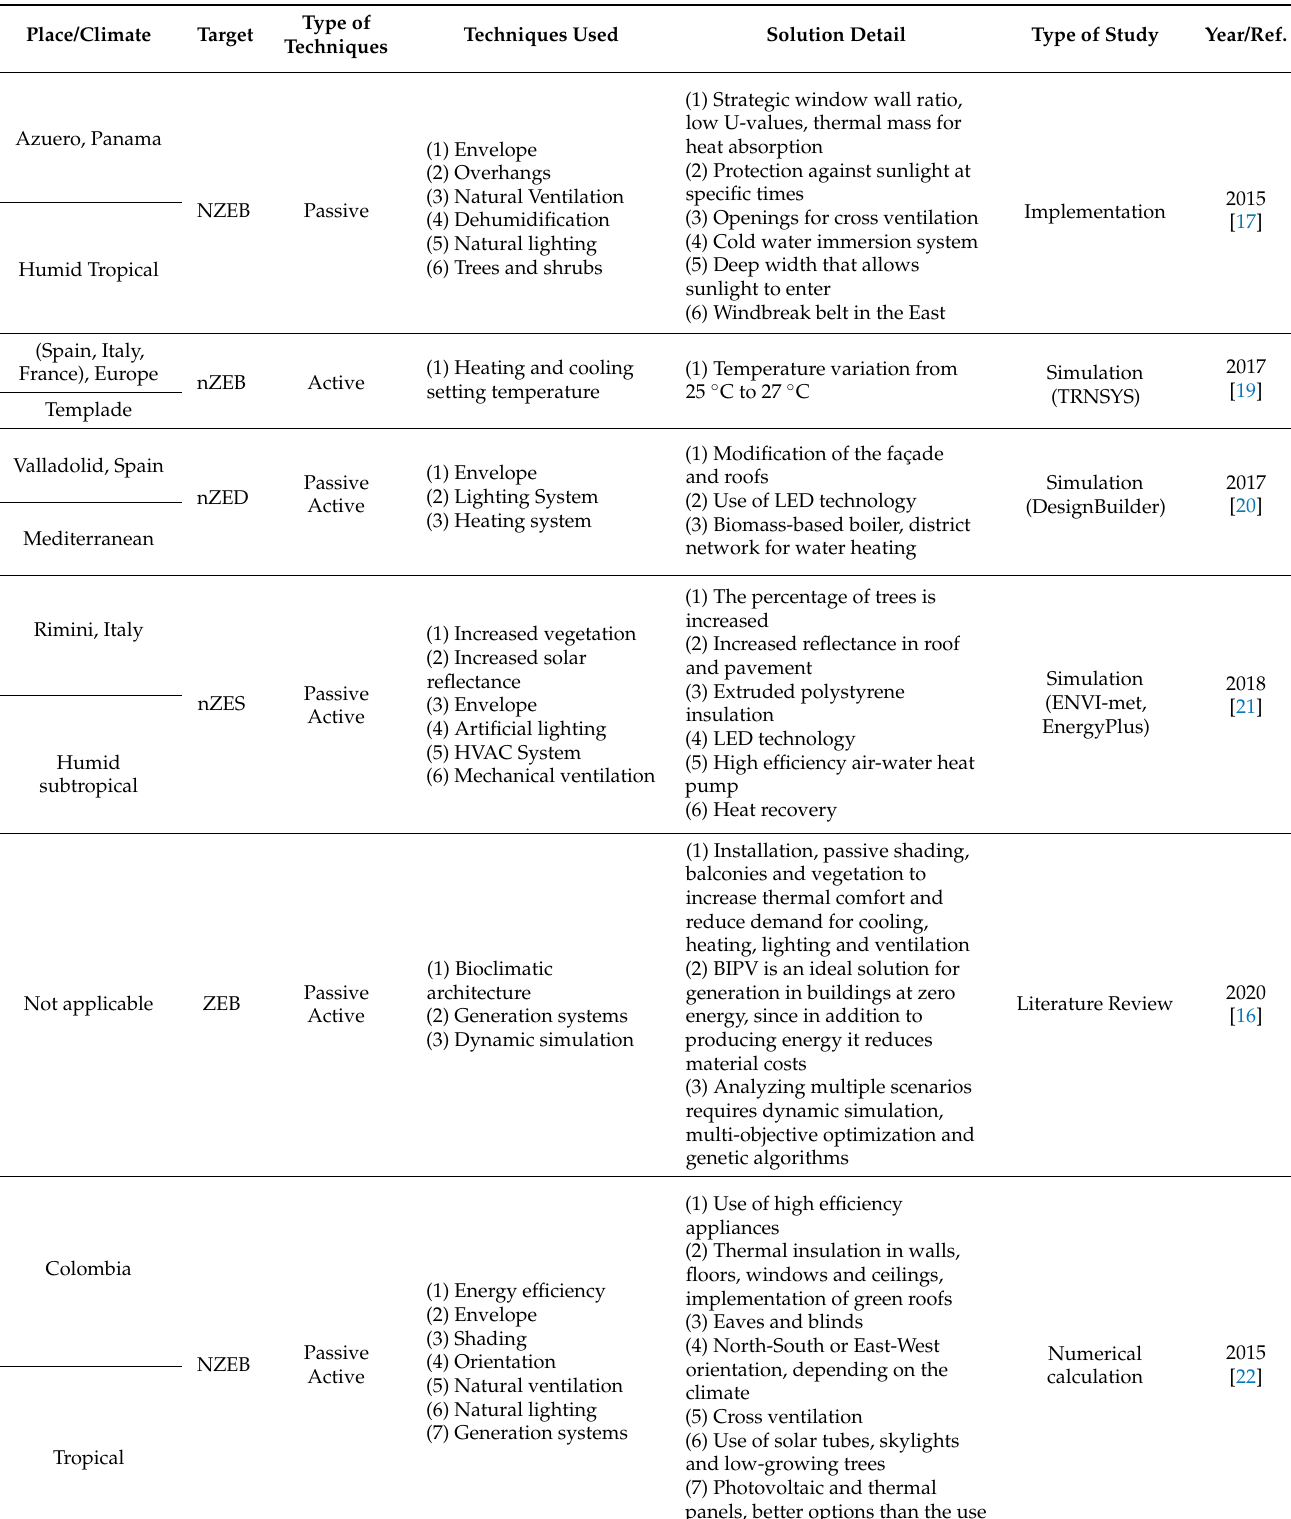
Table 1. Summary of key criteria for the concept of buildings and urbanizations at zero energy, based on passive and active